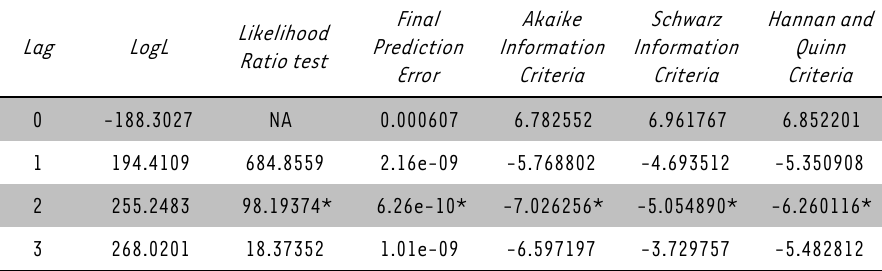
TABLE 2: Lag length